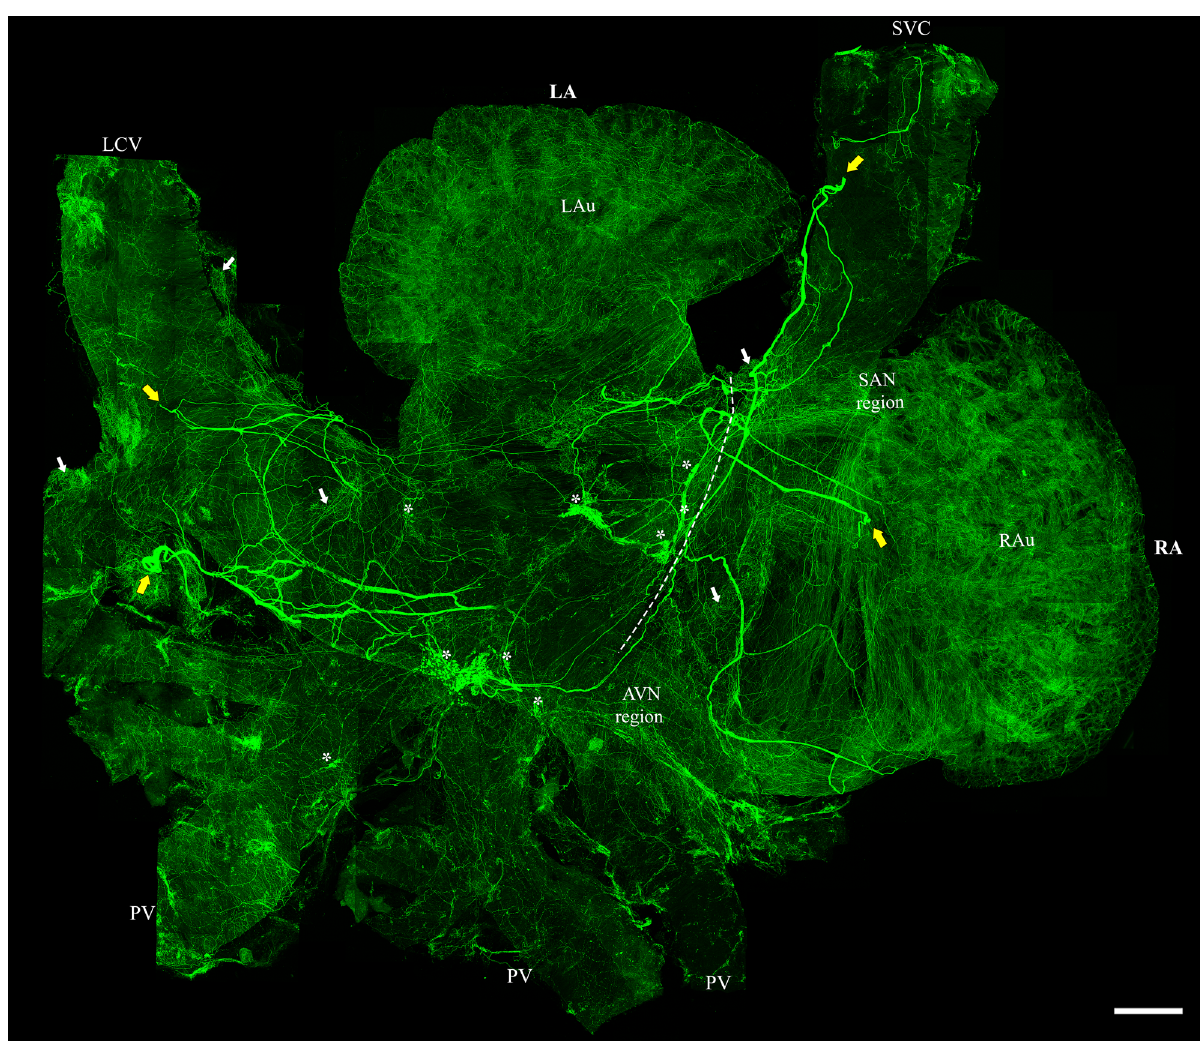
Figure 2. Distribution of TH-IR axons in the flat-mount of the whole atria (RA and LA connected). A montage of 260 maximal intensity projection images showed several large TH-IR bundles that entered the atria and bifurcated into small bundles that innervated the entire connected RA and LA. TH-IR neurons in the ICG were more densely distributed in the LA, junction of LA and RA, entrance of LA to PV. Intrinsic cardiac ganglia (asterisks), Fat (white arrows), junction of LA and RA (dotted line), entrance points (yellow arrows). LA left atrium, RA right atrium, PV pulmonary vein, SVC superior vena cava, LPCV left precaval vein, SAN sinoatrial node region, AVN atrioventricular node region. Scale bar: 500 axons which covered the entire atria (Fig. 2). Across animals, the number of large TH-IR bundles and their entry locations and innervation fields of the atria were quite consistent. In all atrial tissue preparations, most TH-IR bundles were identified consistently at the medial side of superior vena cava (SVC), entrance of the pulmonary veins (PVs) to the left atrium, and left precaval vein (LPCV) (Fig. 3). The tracing of TH-IR axons using the Neurolucida system highlighted the trajectory of major bundles effec- tively. These bundles innervated different regions with a certain degree of overlap (Fig. 4a). TH-IR bundles projected their axons towards the atria via four main topographical pathways: ● Bundle 1 entered the atria at the medial side of the SVC and branched into smaller bundles that proceeded towards the SAN, conductive fibers, AVN region, right PV and the lower part of the right auricle (Fig. 4b). ● Bundle 2 formed a loop around the origin of the SVC (probably folded during dissection) and sent projec- tions mainly to the upper part of the right auricle and junction of LA and RA (Fig. 4c). ● Bundle 3 entered the atria at the LPCV and ramified into individual axons that projected towards the entire left auricle (Fig. 4d). ● Bundle 4 entered the atria at the lower edge of the LPCV and projected towards the LA-PV junction, left and middle PVs and junction of LA and RA (Fig. 4e).